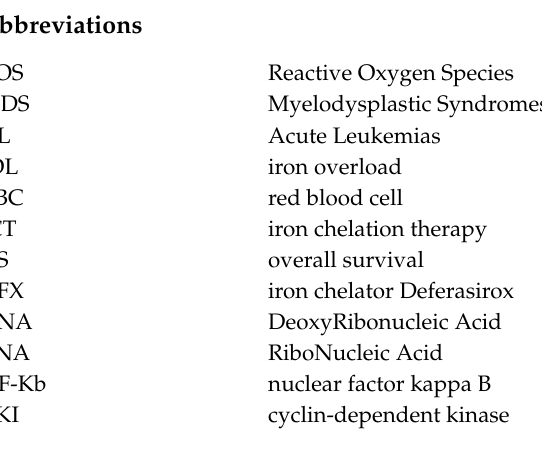
Figure S1: Deferasirox reduces mitochondrial activity and leukemia cell lines’ viability by increasing p53 and p73 protein levels. Figure S2: Iron chelation treatment induces a significant p73 increase in MDS patients’